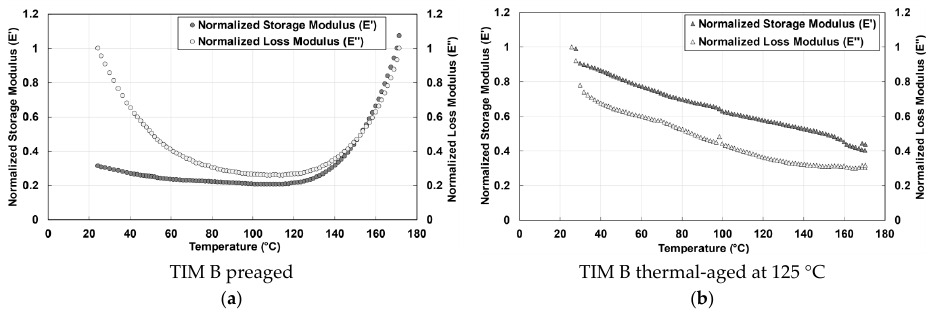
Figure 9. Storage modulus ( E ′) and loss modulus ( E ″), ( a ) TIM B preaged, and ( b ) TIM B thermal-aged at 125 °C.